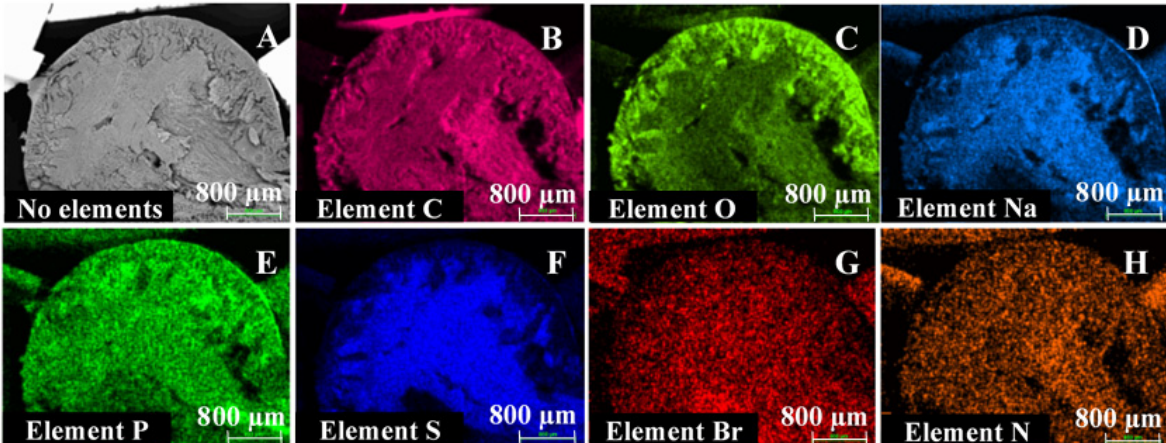
Figure 5. Scanning electron microscopy (SEM) image and energy-dispersive X-ray spectroscopy (EDX) elemental maps of spherical in situ forming gels prepared for formulation 1 containing 200 mg eq./g bedaquiline fumarate salt in PLGA5050A/NMP 20/80% ( w / w ). SEM image (Panel ( A )), EDX maps for carbon coloured pink (Panel ( B )), oxygen coloured green (Panel ( C )), sodium coloured blue (Panel ( D )), phosphor coloured green (Panel ( E ), sulphur coloured blue (Panel ( F )), bromine coloured red (Panel ( G )), and nitrogen coloured orange (Panel ( H )).